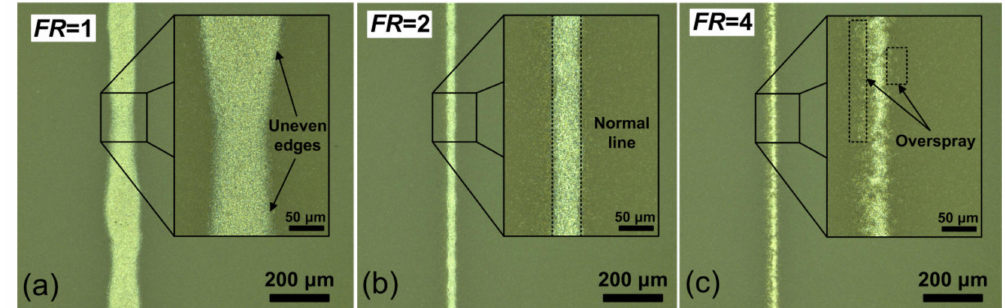
Figure 3. Optical images of platinum lines formed at different values of focusing ratio ( a ) FR = 1, ( b ) FR = 2, ( c ) FR = 4, and inserts with higher magnifications.